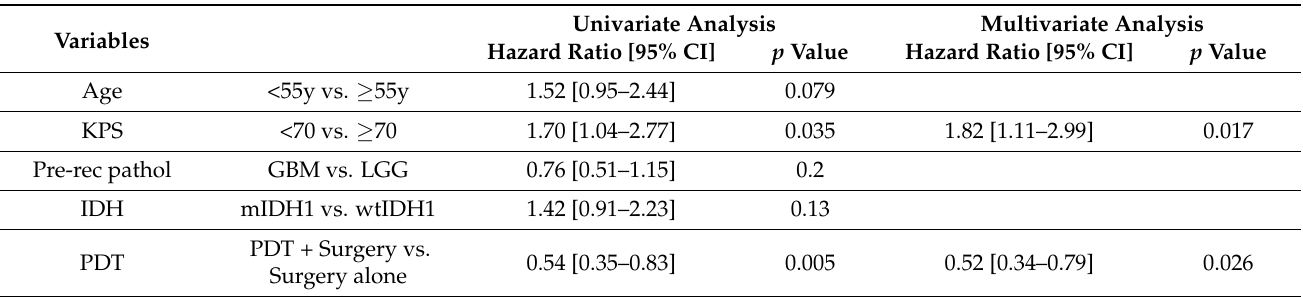
Table 2. Univariate and multivariate analyses for PFS. Table 3. Univariate and multivariate analyses for